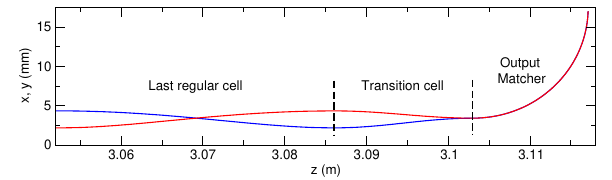
Figure 4. Characteristics of the last cells of the RFQ.